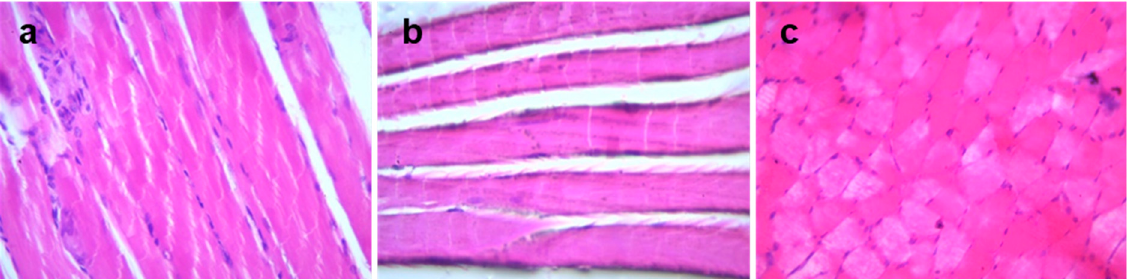
Figure 3. Morphological evaluation of hind muscle of irisin-treated rats. Hind muscle tissue sections of ( a ) control animals and ( b , c ) irisin (pump)-treated animals (×40).